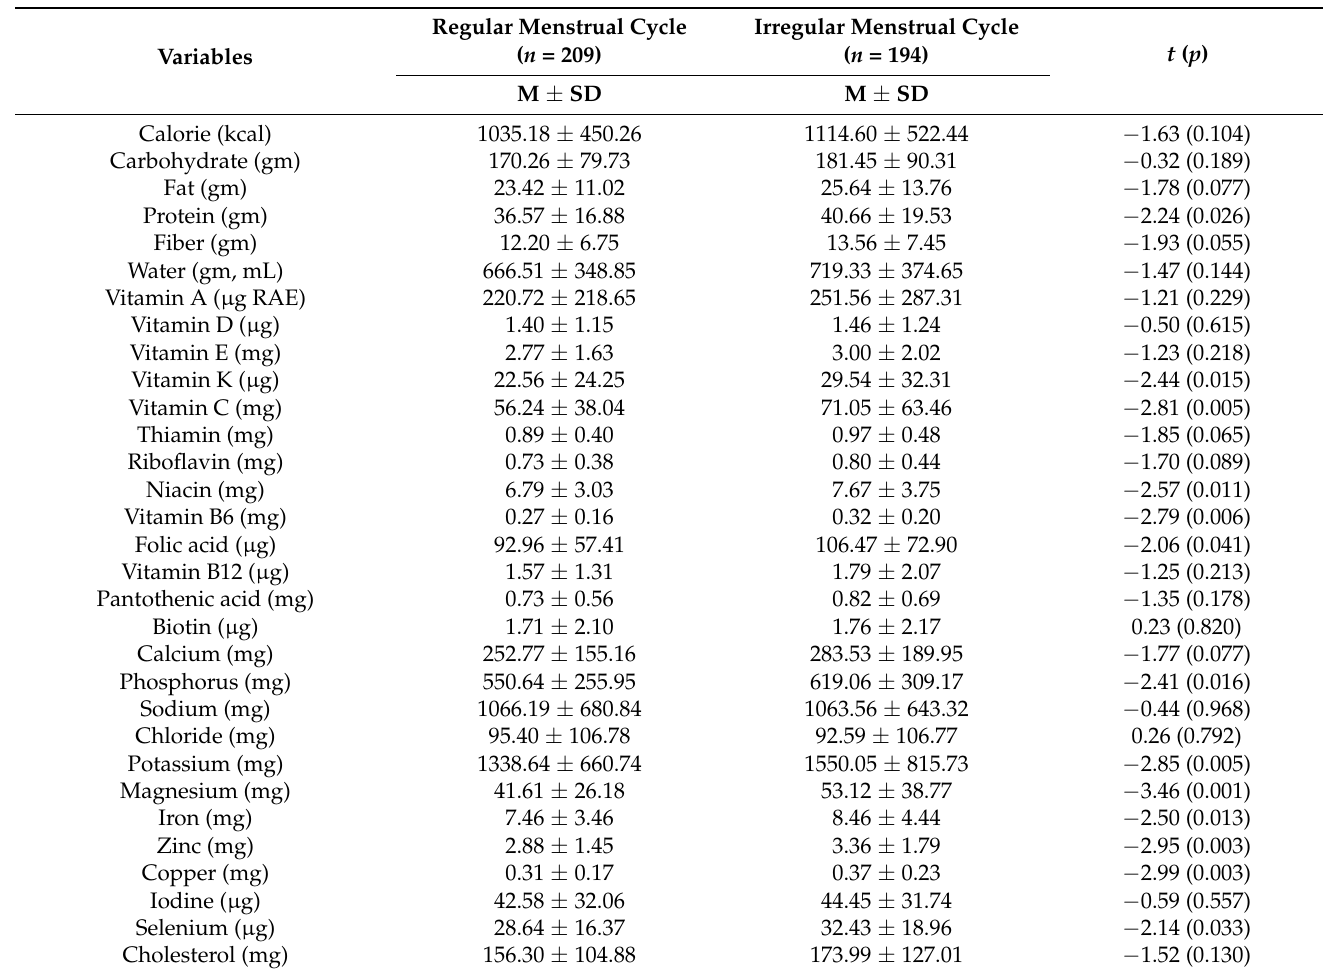
Table 3. Nutrients according to menstrual cycle regularity ( n =